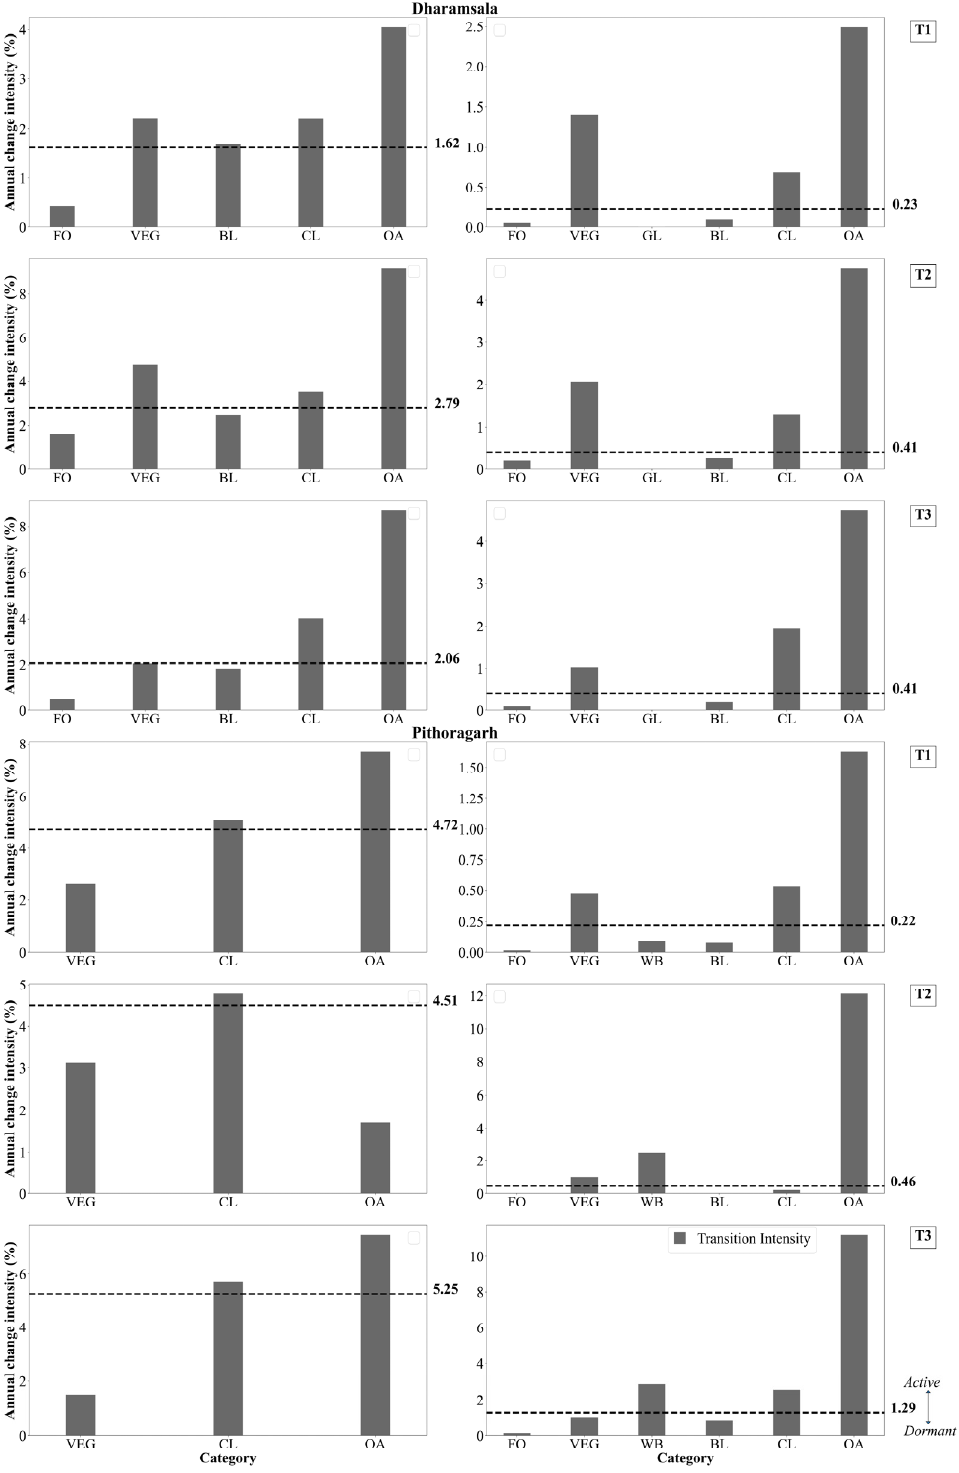
Figure 5. Transition level changes in terms of intensity during three time intervals in Dharamsa-la and Pithoragarh, at the city level (Column 1) and outer zone (Column 2). FO: forest, VEG: vegetation, WB: waterbody, BL: barren land, CL: cropland, OA: open area. At the Pithoragarh city level, the expansion of built-up land targeted open area dur- ing T1 and T3 the most, while, during the most active period T2, cropland was the most active target for transitions. However, in the outer zone, open area was the most actively targeted LULC type for built-up transitions, followed by cropland and vegetation. In the